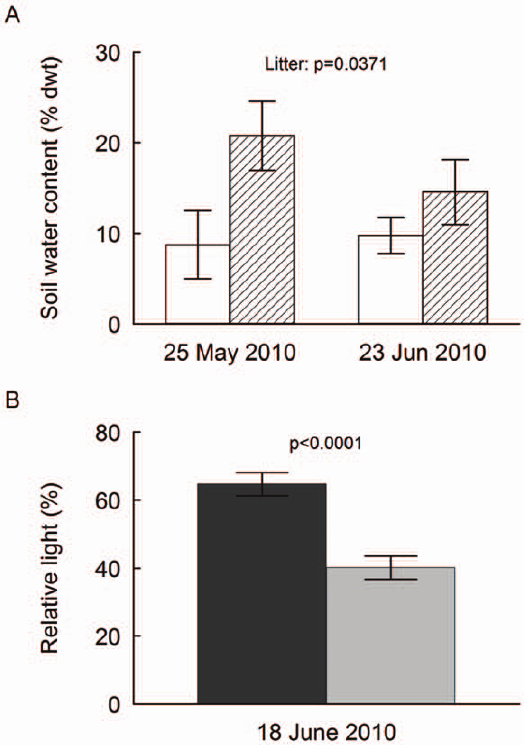
Figure 2. Soil water content and light availability. Gravimetric soil water content (A) in large plots (0.1 m 2 ) at two occasions during the time of initial seedling growth (25 May, 23 June) and relative light intensity (B) in large and small plots (0.01 m 2 ) ca. 3 cm above the soil surface on 18 June. In a., white bars denote control plots (without litter), hatched bars plots with litter (initially 400 g m 2 2 ). Data are means 6 s.e., n=3. Analysis of variance showed a significant litter effect (F 1,8 =6.24, p=0.0371), whereas the effects of date and the litter x date interaction were not significant. In b., the black bar denotes large plots, the gray bar small plots. Data are means 6 s.e., n=150). Analysis of variance showed significant effects of plot size (F 1,288